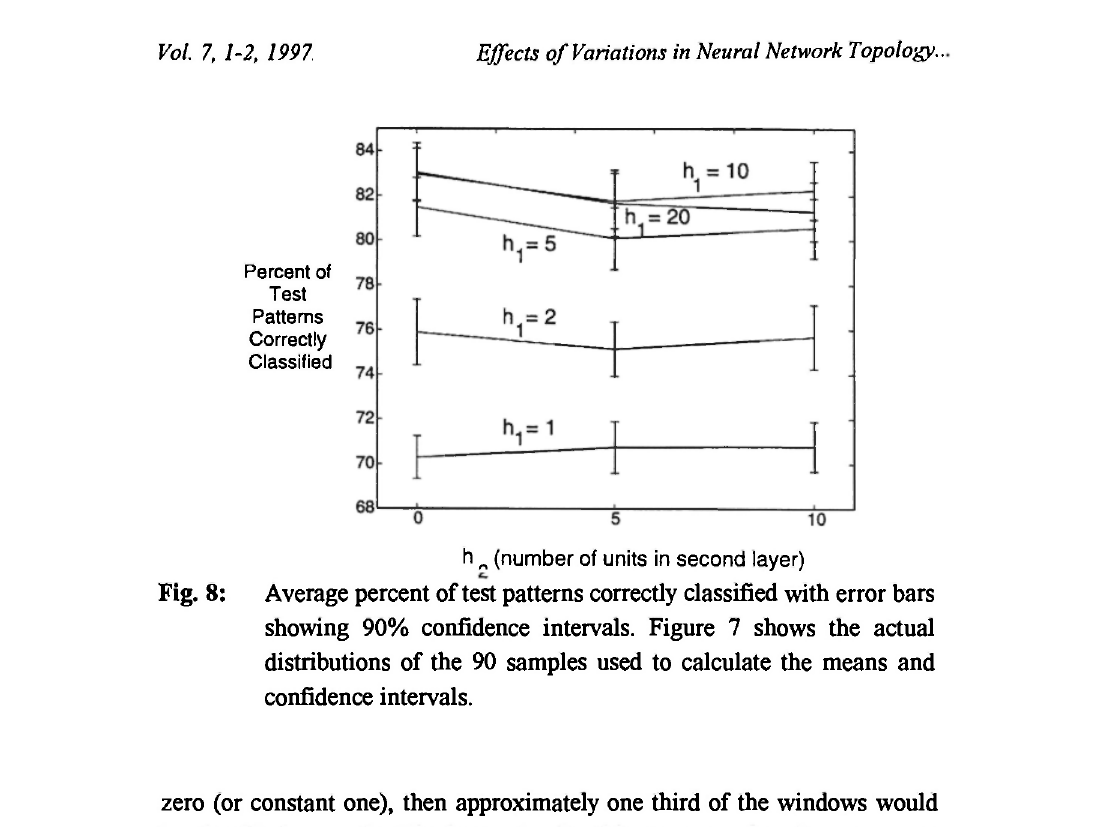
Fig. 8: Average percent of test patterns correctly classified with error bars showing 90% confidence intervals. Figure 7 shows the actual distributions of the 90 samples used to calculate the means and confidence